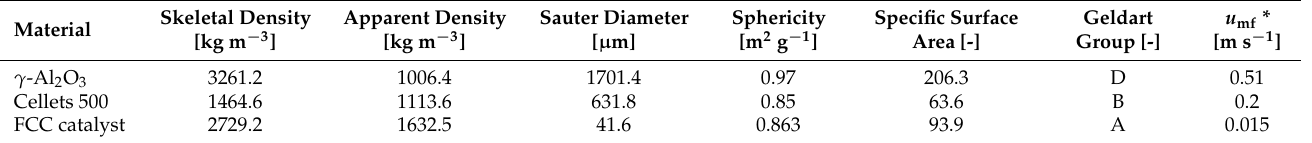
Table 1. Overview of relevant properties of the materials used in experiments and